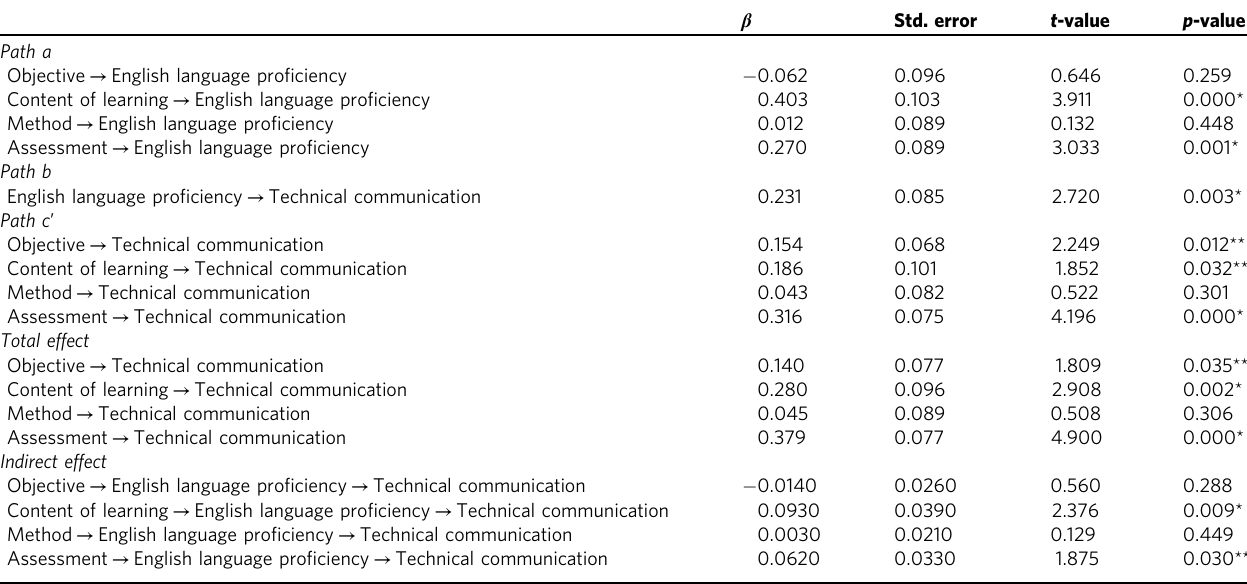
Table 17 Mediation analysis